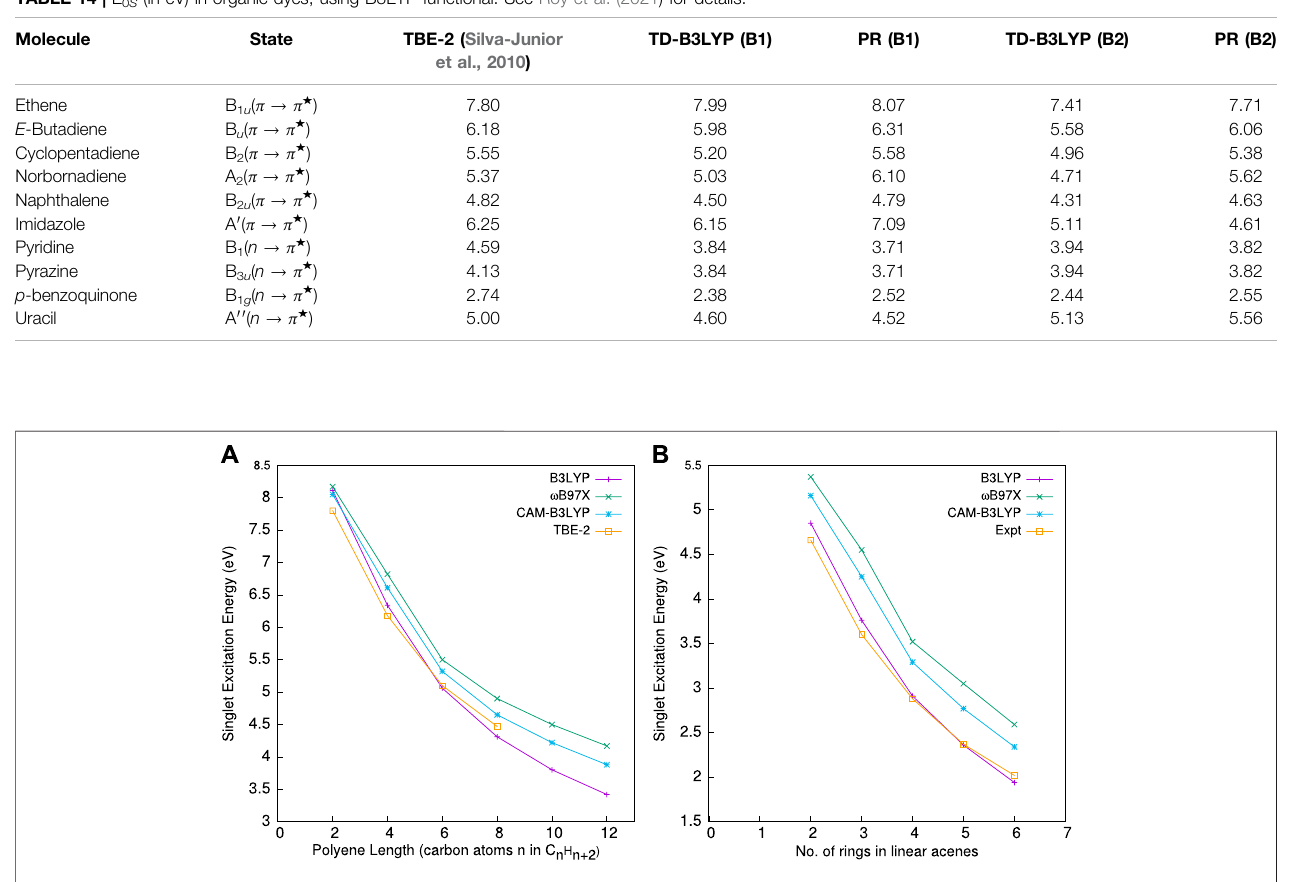
FIGURE3| E 0 S withdifferentfunctionalsagainst (A) polyenelengthand (B) thenumberofrings.BothpanelsemployaB1basis.MoredetailsaregivenbyRoyetal. (2021).